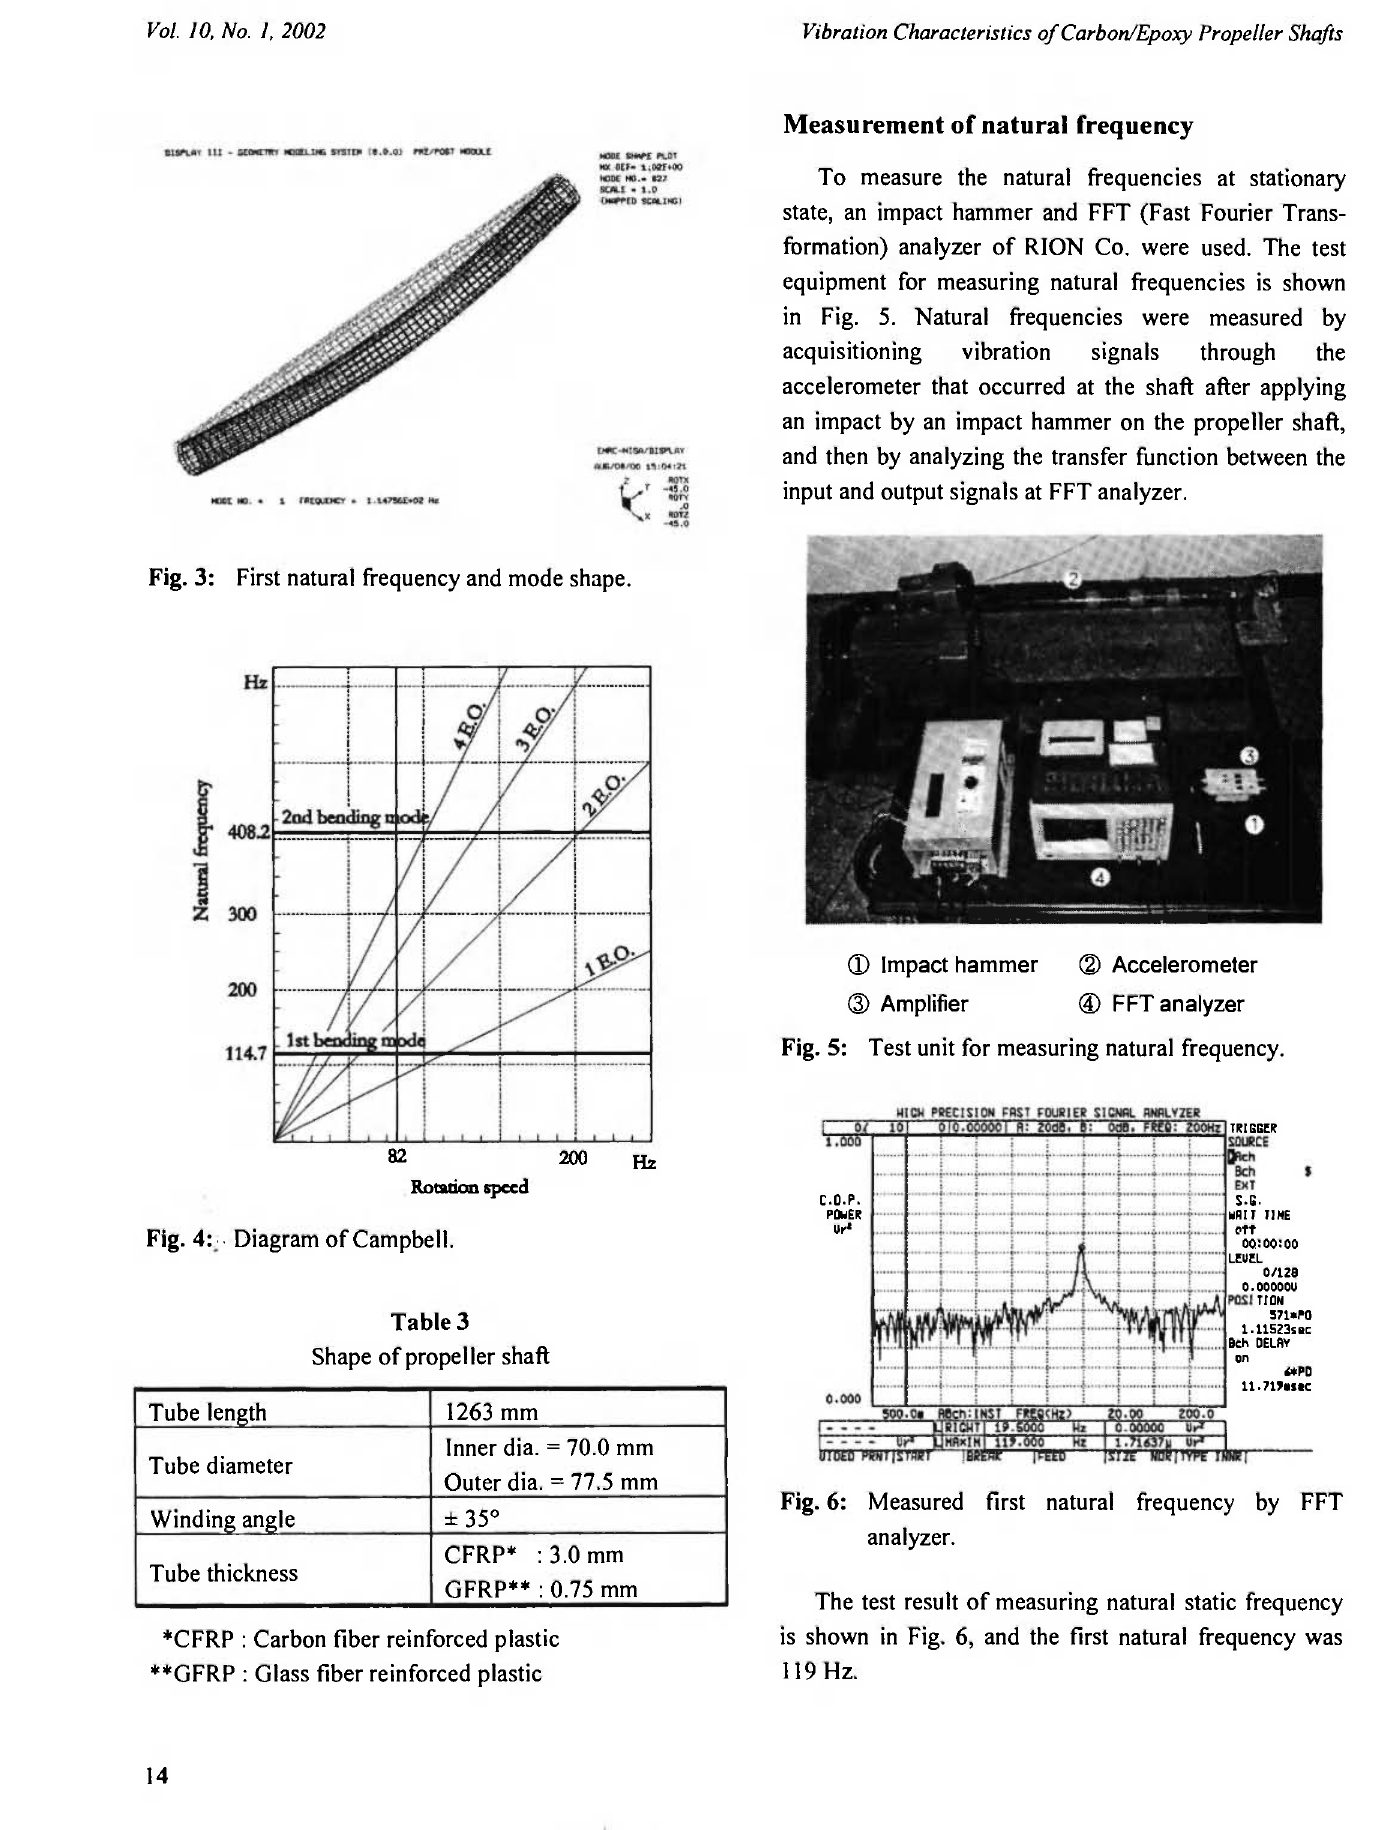
Fig. 6: Measured first natural frequency by FFT analyzer. The test result of measuring natural static frequency